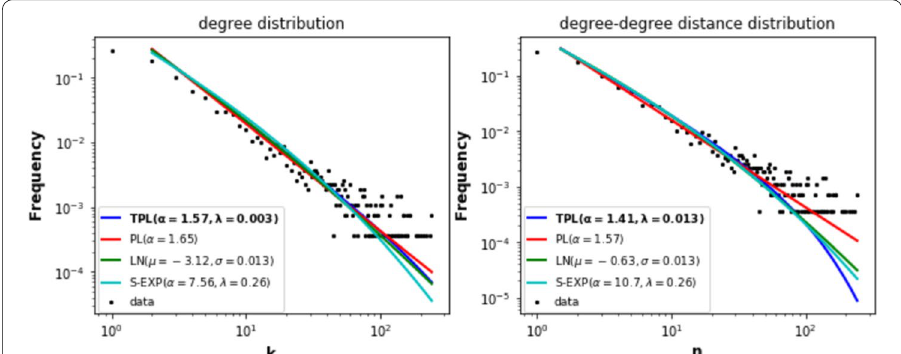
Fig. 14 The degree (left) and degree-degree distance (right) distributions of the world air transportation network. Empirical distribution (dot), estimates (line). The distribution under test are: power law (PL), truncated power law (TPL), log-normal (LN) and stretched exponential (S-EXP). The values in bold are the parameters of the best fit according to the Kolmogorov-Smirnov